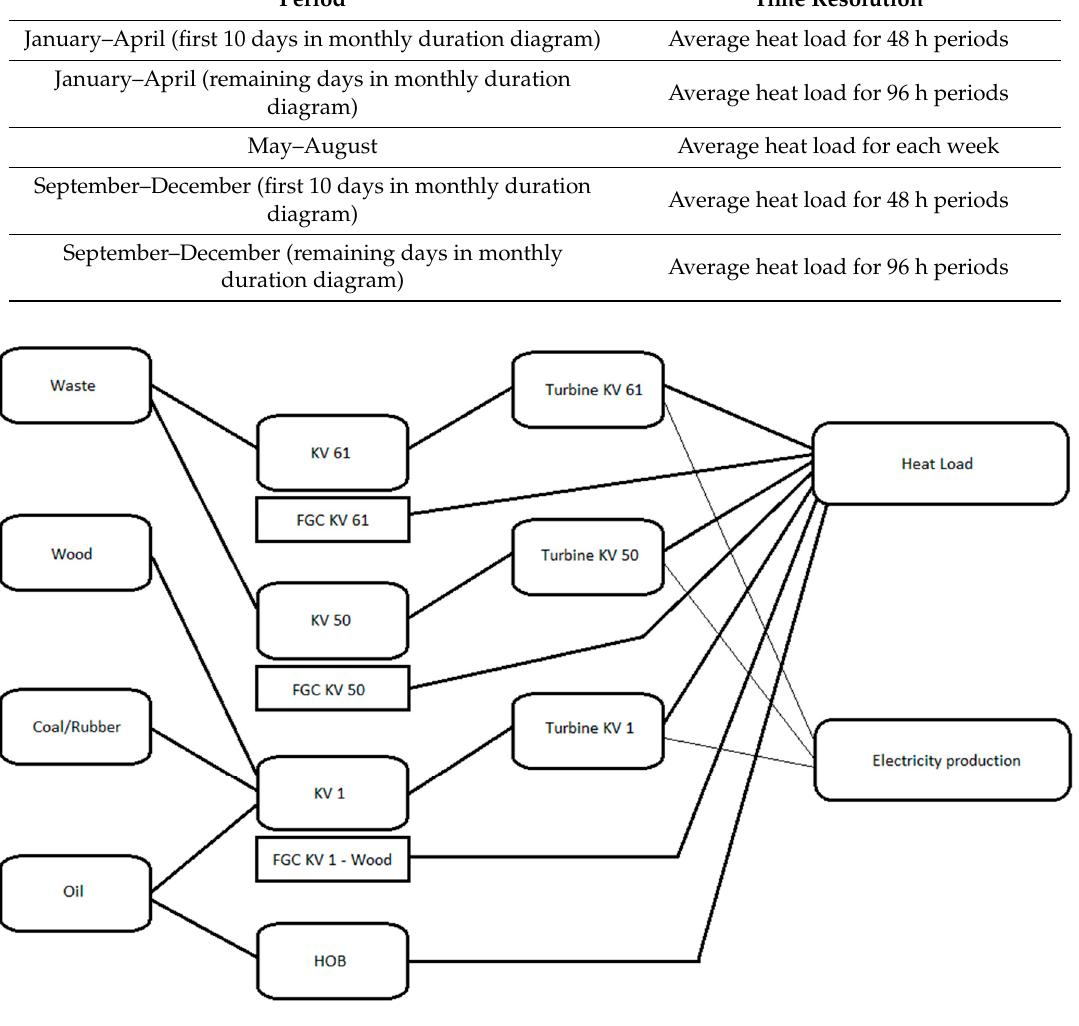
Figure 5. Illustration of nodes and flows in the model. Table 3. Fuel prices in the model. CHP—combined heat and power.